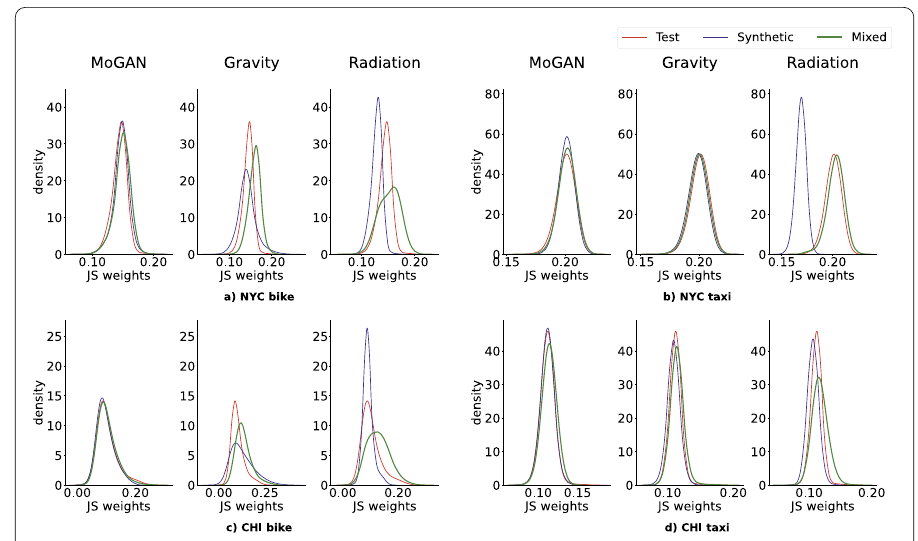
Figure 6 Results for weights distribution. Distributions of the pairwise JS distance between the distribution of weights of the mobility networks in the test set (red), synthetic set (blue), and mixed set (green), for the four different datasets. For each dataset, we compare the overlap of the distributions of MoGAN and the two baselines (Gravity and Radiation). The Radiation model’s mixed and synthetic sets distributions significantly differs from the test set for all datasets. The situation is similar for the Gravity model performances. MoGAN distributions are almost overlapping for all four datasets